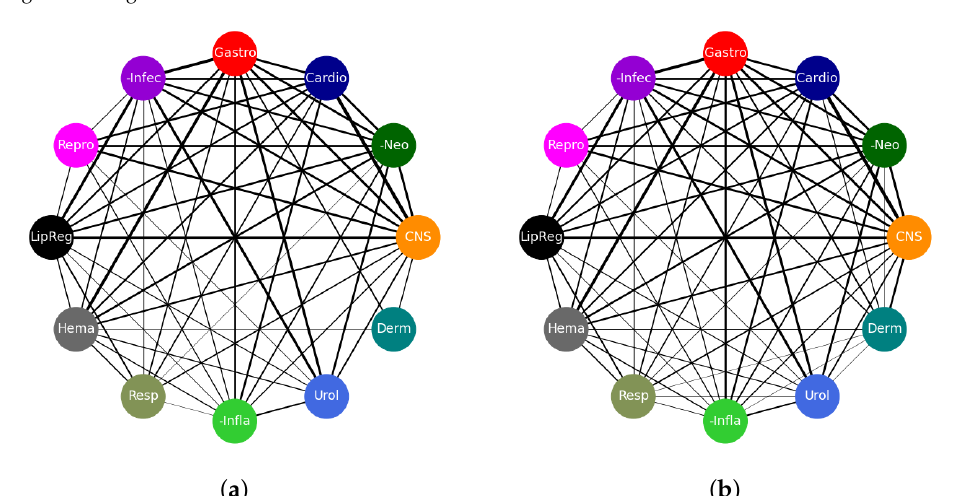
Figure 7. Networks of multi-label classification on the test dataset. The connections as given by true class labels are shown in ( a ) while those predicted by the model are shown in ( b ). In each of these subfigures, the thicker the edge the higher the frequency of co-occurrence of nodes. There are seven edge types that appear in the network of predictions that do not appear in the network of true class labels. These are urological–dermatological, antineoplastic–dermatological, respiratory–urological, anti-inflammatory–dermatological, anti-infective–dermatological, cardiovascular–dermatological, and respiratory–dermatological. Such new edge types show the obvious misclassifications made by the model. Other misclassifications are more subtle and can be seen by the widths of the edges. We have provided the list of edge counts for that case in the Supplementary Material. Networks in this figure were drawn using NetworkX